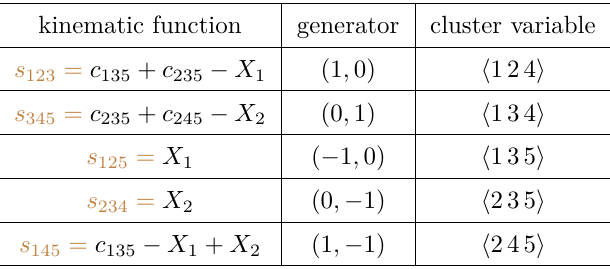
Table 4. The correspondence between kinematic functions, generators, and cluster variables for the C (3 , 5) polytope according to the “right” conventions, shown in figure 8, in contrast to table 1 which shows the correspondence for the “left”